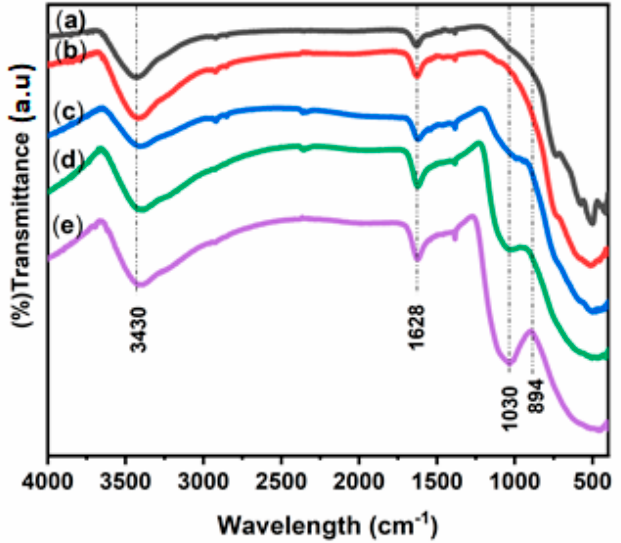
Figure 4. FT-IR spectra of 3.6wt%V 2 O 3 /ZrO 2 modified P depending on P/V value ( a ) ZrO 2 , ( b )